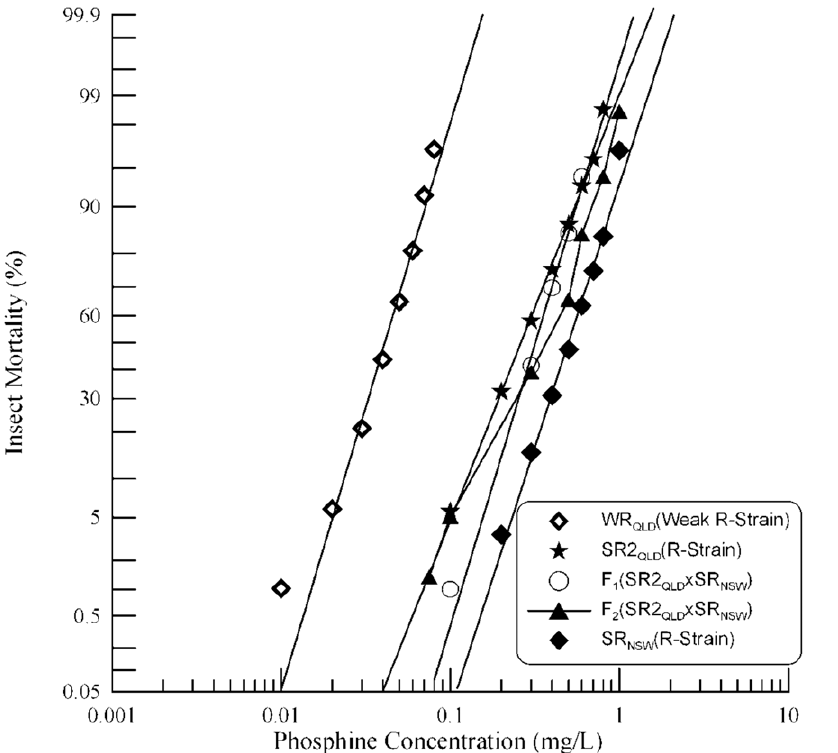
Figure 6. Resistance response of F 1 hybrids and F 2 progeny of a cross between strongly resistant R. dominica strains from Queensland and New South Wales. Results are presented as log-dose mortality of the F 1 hybrids and the F 2 progeny with reference curves of the parental strains, SR2 QLD and SR NSW , and the weakly resistant strain from Queensland (WR QLD ). Phosphine exposure was for 48 hours at 25 u C and 70%